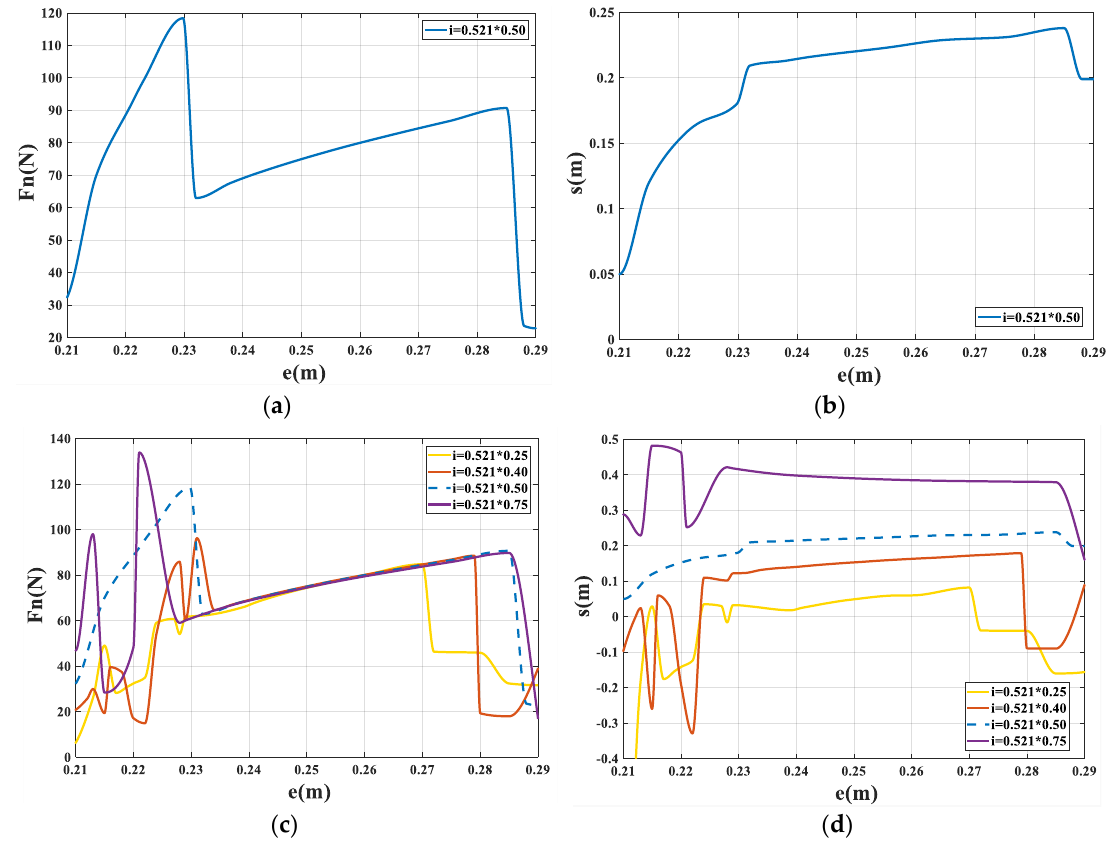
Figure 12. Changes in support force ( a ) and support force position ( b ) with the length of the putter e when the center of gravity is at the center of the robot (j = 0.521 × 0.5 m) and changes in support force ( c ) and support force position ( d ) with the length of the putter e (the center of gravity is not at the center of the robot).